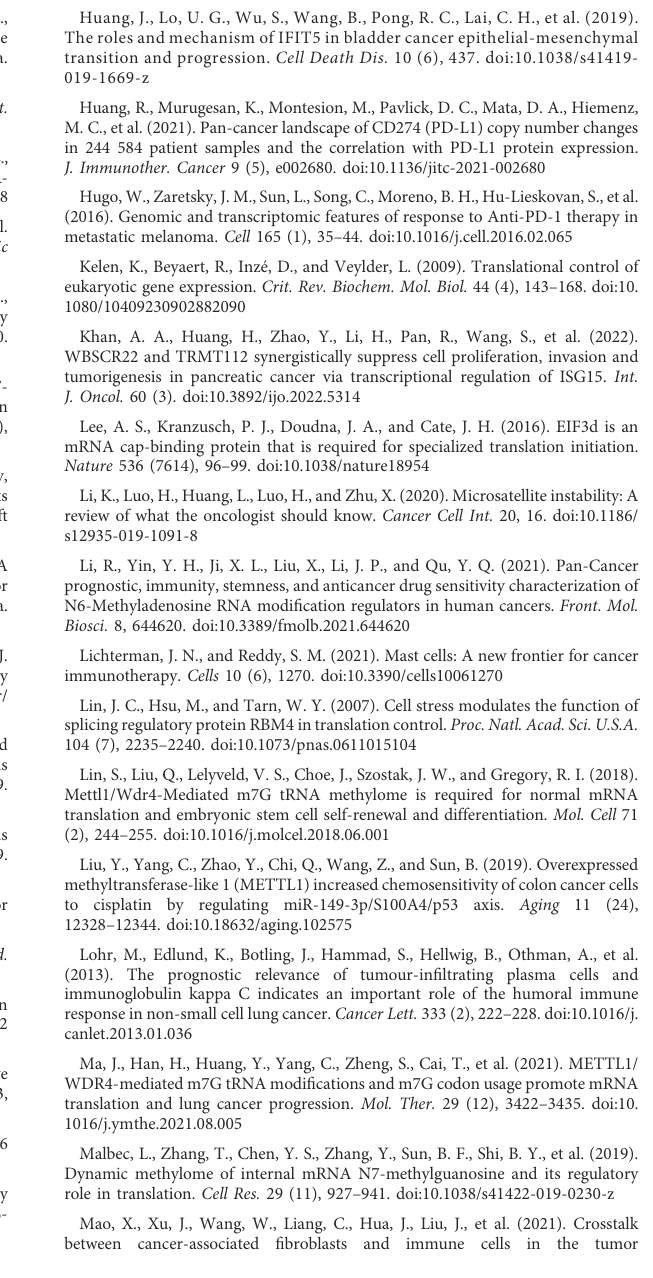
SUPPLEMENTARY FIGURE S4 Correlation analysis between 31 m7G regulators expression and clinical characteristics in LUAD and LUSC, respectively. SUPPLEMENTARY FIGURE S5 Correlation analysis of m7G regulators and LUAD, LUSC microenvironment, and stem cell scores. (A) The correlation relationship between m7G methylation regulators expression and immune score, stromal cell score, stem cell score and immune microenvironment in LUAD. (B) The correlation relationship between m7G methylation regulators expression and immune score, stromal cell score, stem cell score, and immune microenvironment in